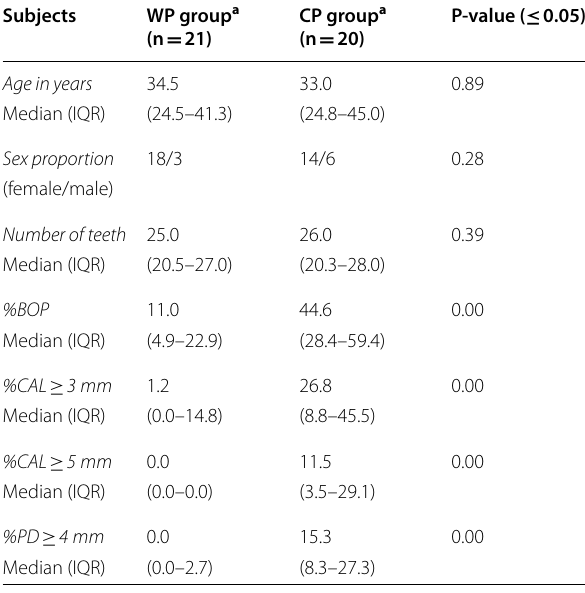
Table 1 Characteristics of subjects without periodontitis and patients with chronic periodontitis (Brazil, 2018)